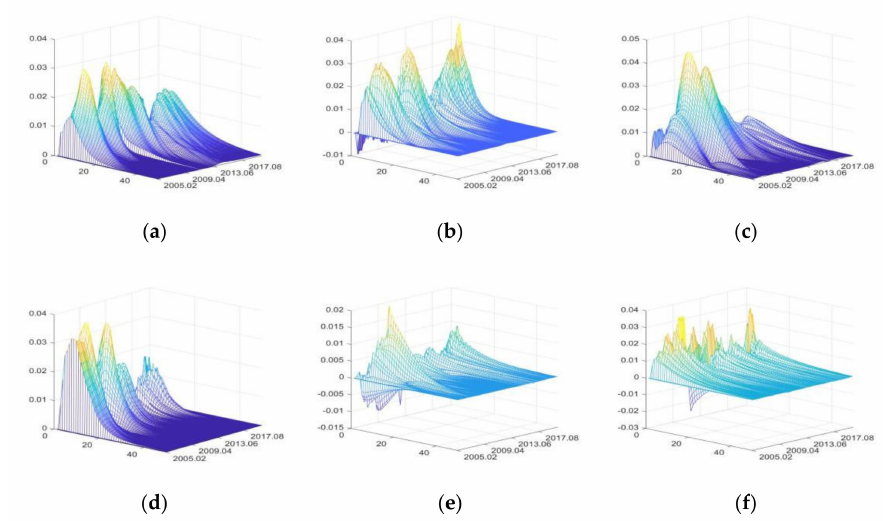
Figure 9. The three-dimensional impulse responses of SPFE to positive shocks of external uncer- tainties. ( a ) Shocks of IRU. ( b ) Shocks of FU. ( c ) Shocks of SDU. ( d ) Shocks of CU. ( e ) Shocks of DE. ( f ) Shocks of PHE.